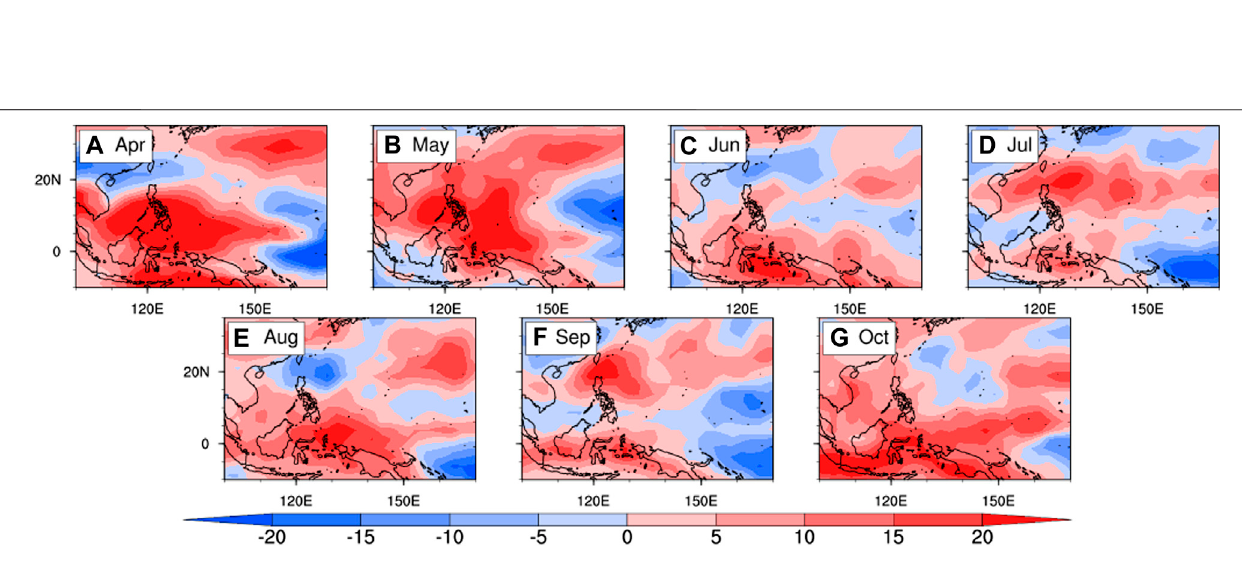
Frontiers in Earth Science |